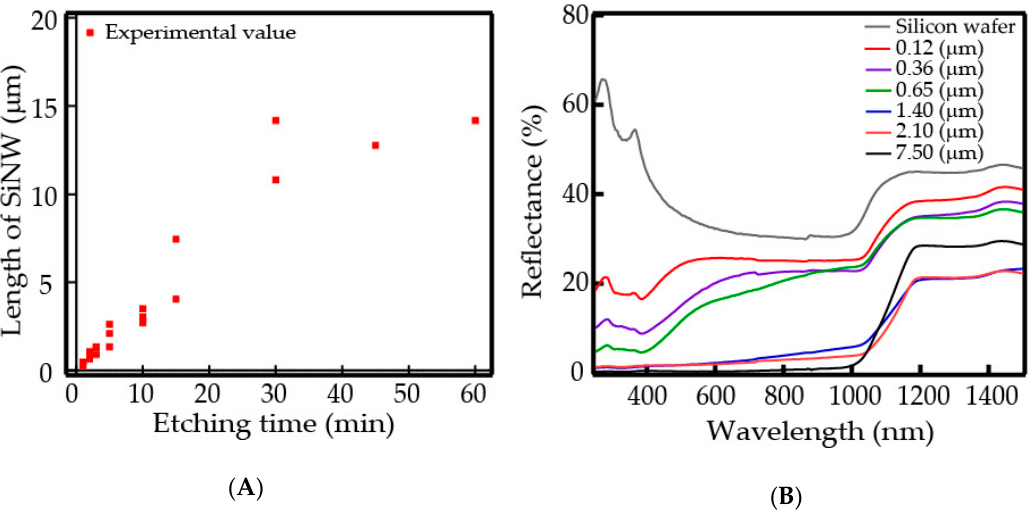
Figure 5. ( A ) Dependence of the SiNW array length on etching time. ( B ) Reflectance of the SiNW arrays with different array lengths.